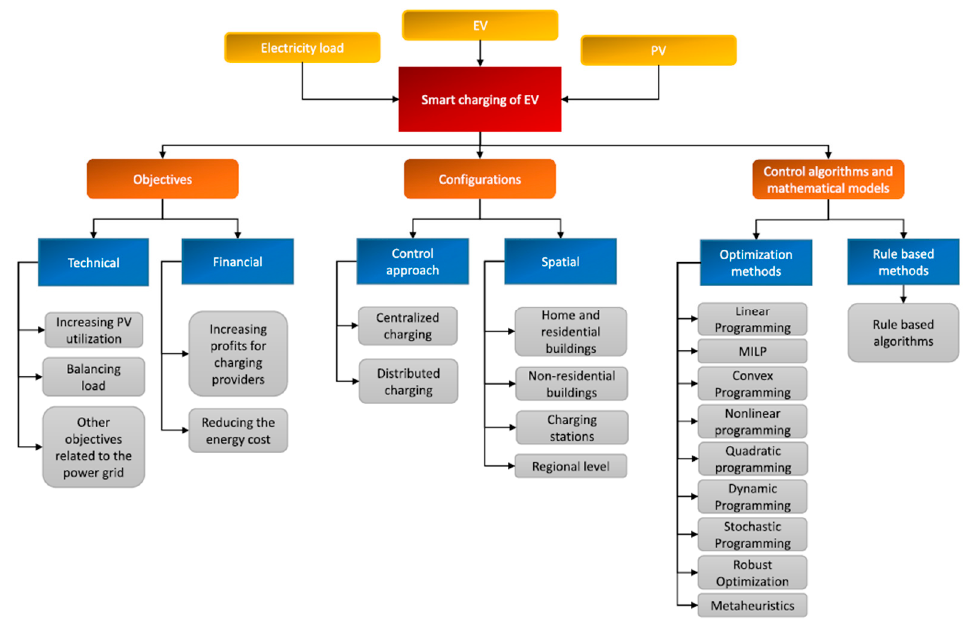
Figure 14. The synthesis of charging optimization studies of [86].